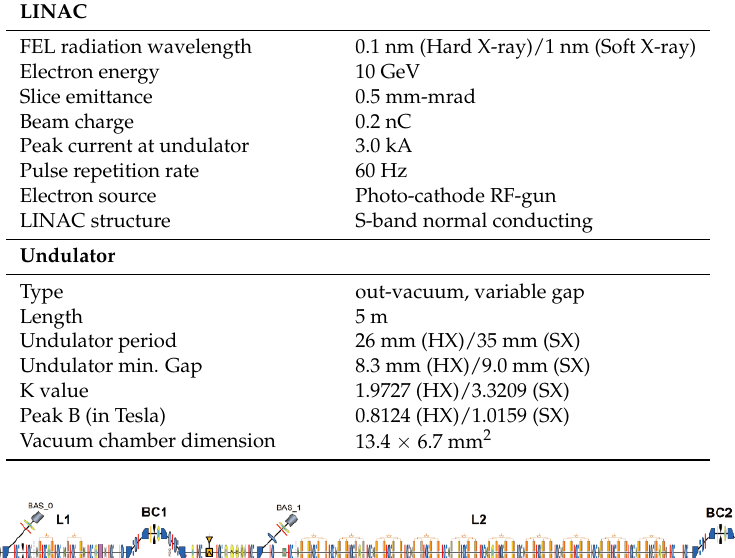
Table 2. Major parameters of PAL ‐ XFEL.